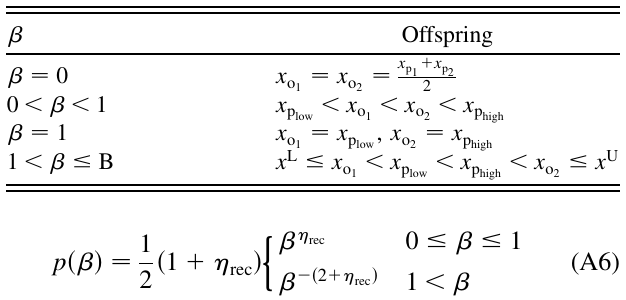
parallels the rec . As mut ! 1 , the pdf rec